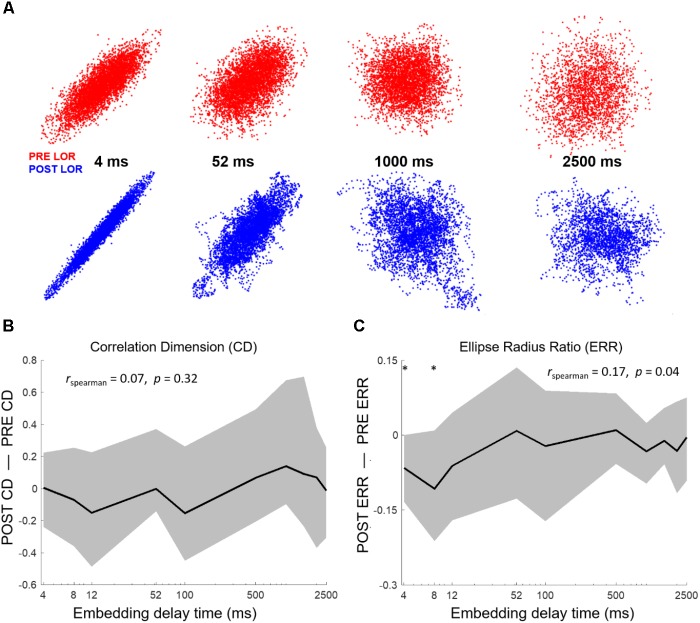
Attractor shape changes are embedding delay dependent. (A) Attractors from PT02 shown at 4, 52, 1000, and 2500 ms. The shape change in the attractor is not observed at higher embedding delays. We tested whether our attractor characterization analyses correlated with embedding delay. We computed correlation dimension and ellipse radius ratio (ERR) at 10 different delays from 4 to 2500 ms. (B) No significant changes in correlation dimension were observed from before to after LOR for any embedding delay nor was correlation dimension correlated with the embedding delay. Here we show results from the 3D correlation dimension calculation. (C) We observed a significant correlation between the ERR and embedding delay (rspearman = 0.17, p = 0.04) and a significant difference in the ERR between pre- and post-LOR for 4 ms and 8 ms delays (p4 = 0.017 corrected, p8 = 0.04 corrected). The ∗ indicates a significant difference between the measured values before and after loss of response at that embedding delay at p < 0.05 corrected.